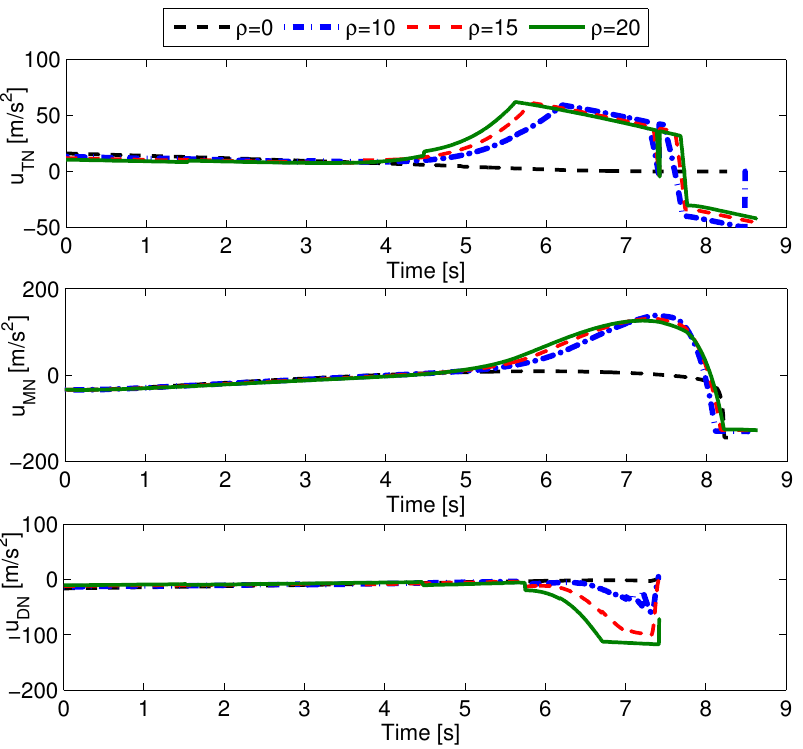
Figure 6. Guidance commands of three aircraft with different ρ . Table 2. Simulation results in different